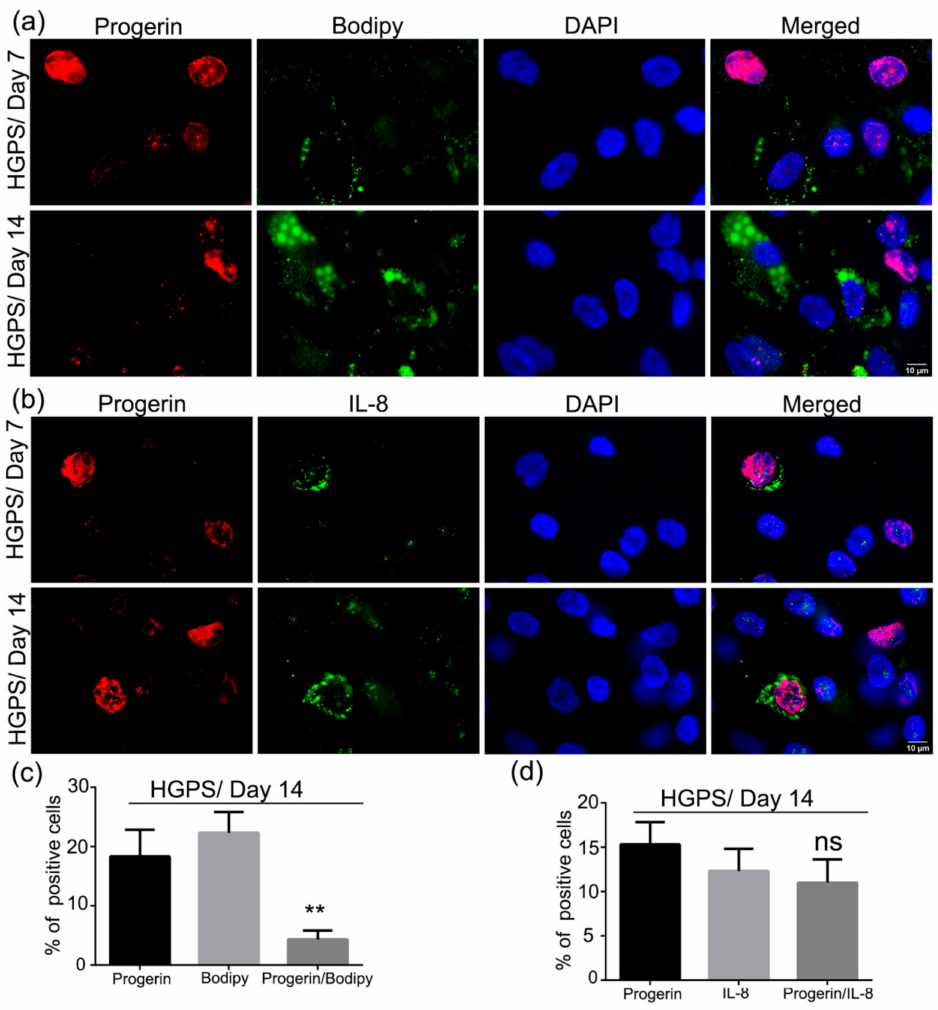
Figure 9. Co-expression of progerin with Bodipy and IL-8 in HGPS differentiated SKPs. ( a ) Im- munofluorescence staining for progerin and Bodipy at days 7 and 14 of adipogenesis in HGPS (HGADFN127). ( b ) Immunofluorescence staining for progerin and IL-8 at days 7 and 14 of adipoge- nesis in HGPS. Cells were counterstained with DAPI. ( c ) Percentage of positive nuclei expressing either progerin, Bodipy, or both (progerin/Bodipy 493/503). ( d ) Percentage of progerin-positive nuclei, IL-8-positive or progerin/IL-8-positive cells. Values are presented as mean ± SD ( n = 3), not significant (ns), ** p < 0.01, ( c , d ) unpaired t